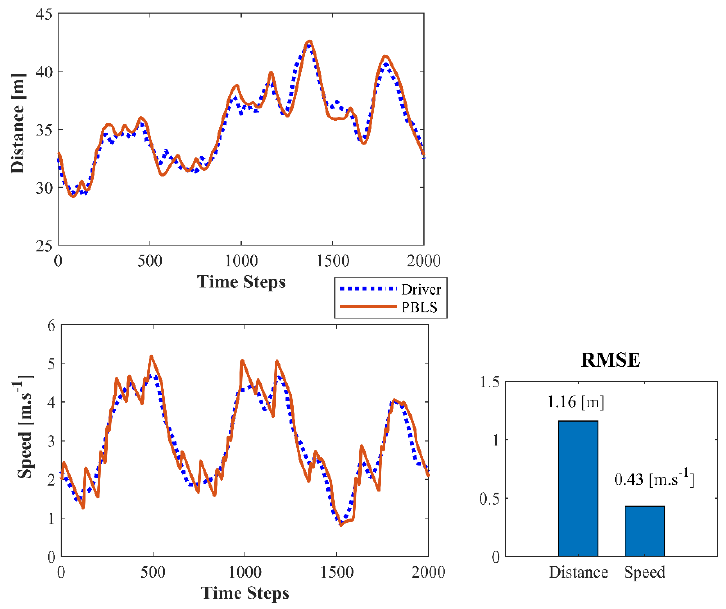
Figure 14. Test result for Driving Scene III.